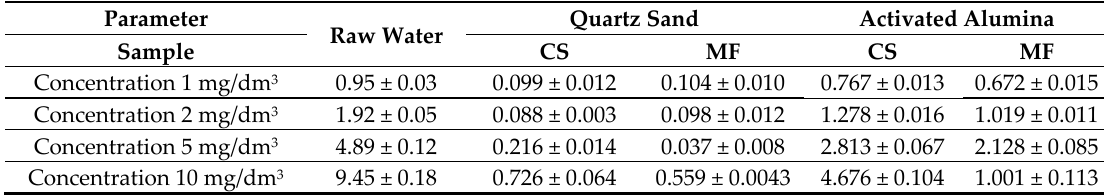
CS: Control sample, MF: Water sample subjected to magnetic